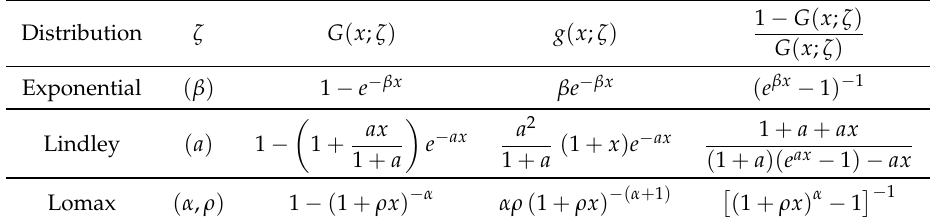
Table 1. Some examples of baseline lifetime distributions which can be used to define special members of the transmuted odd Fréchet-G (TOFr-G)